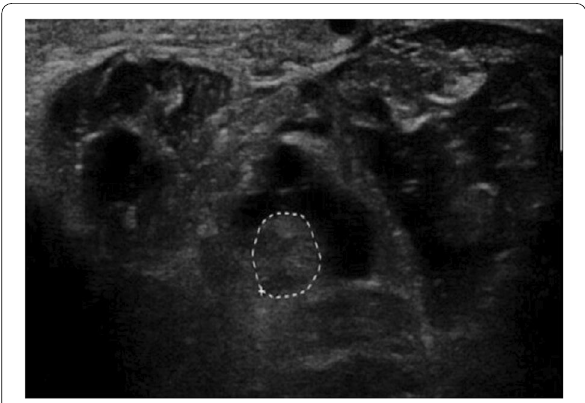
Fig. 1 Measurement of tibial nerve CSA by high resolution